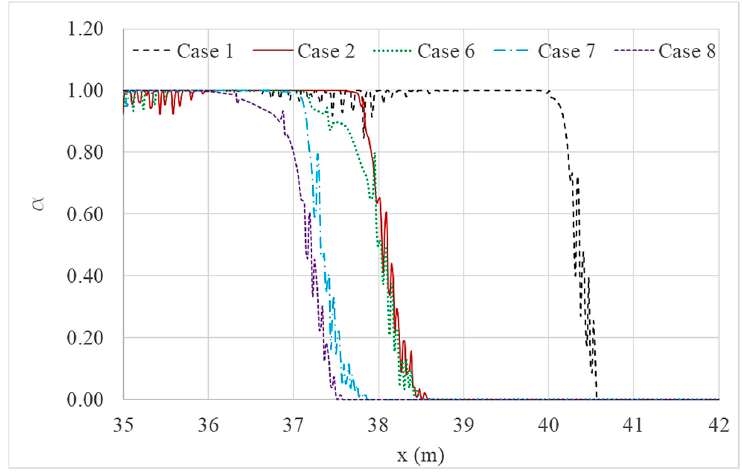
Figure 18. Comparison of wave run-up for each simulation case with different trench widths.